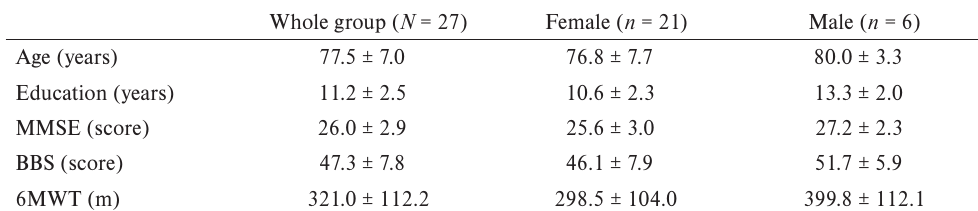
Demographic characteristics of the sample (M ±